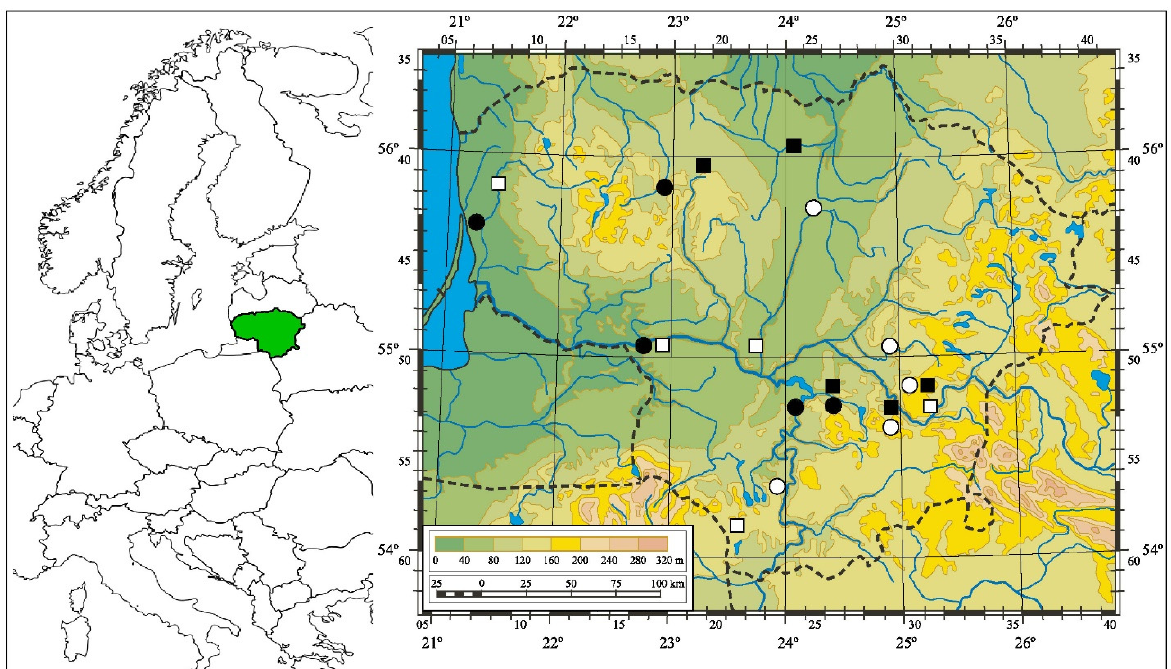
Figure 1. Location of the Cornus seed bank sampling sites in Lithuania. White dots— C. alba ; black dots— C. sericea ; black squares— C. sanguinea subsp. australis ; white squares— C. sanguinea subsp. sanguinea . Table 1. List of the study sites of the Cornus soil seed bank in Lithuania, with their administrative position, geographical coordinates and EUNIS habitat